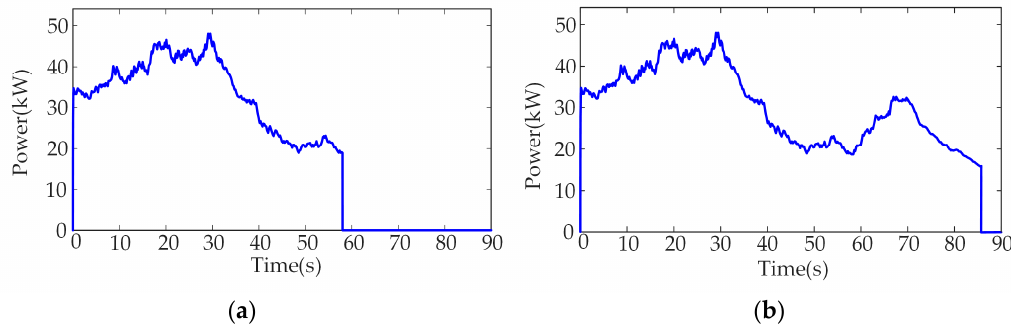
Figure 19. Power curves. ( a ) Power of G1; ( b ) power of G2.